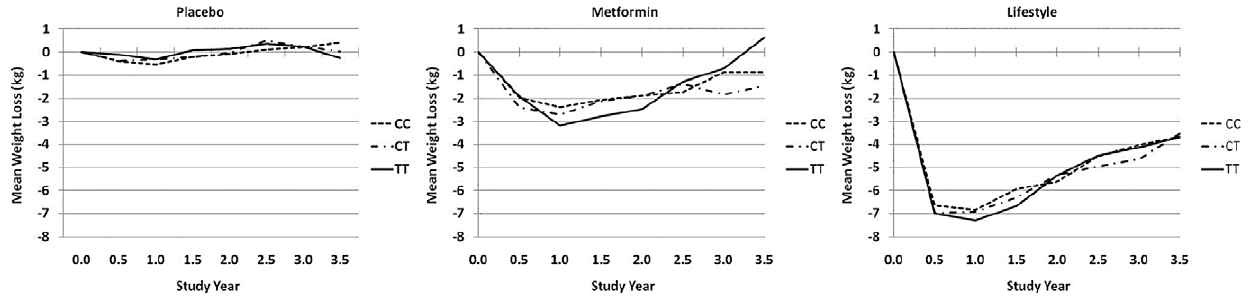
Figure 1. Mean weight loss in the Diabetes Prevention Program by treatment group and genotype at rs7903146.